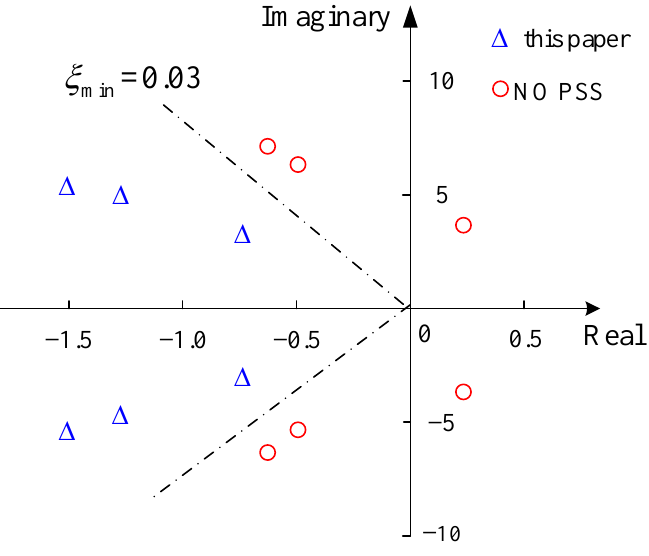
Figure 14. Distribution of